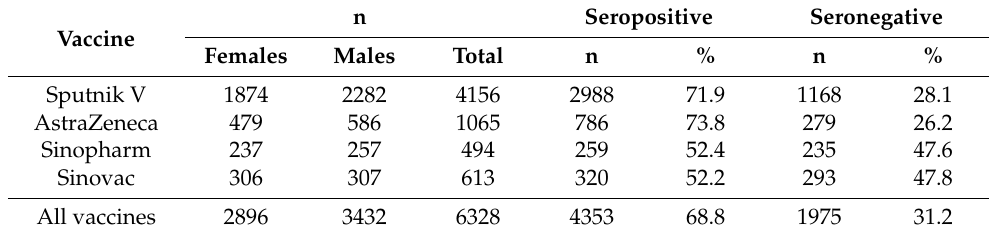
Table 1. Distribution of vaccinated participants by sex, vaccine type, and IgG seropositivity. n Seropositive Seronegative Vaccine Females Males Total n % n %